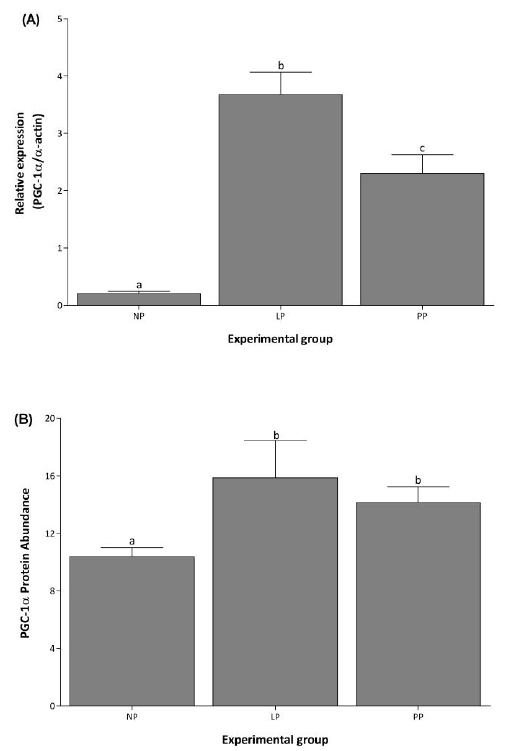
Figure 3. PGC-1 α increases in the left ventricle during pregnancy. Mean ( ± S.E.M.) mRNA expression Figure 3. PGC- 1α increases in the left ventricle during pregnancy. Mean (± S.E.M.) mRNA expres-